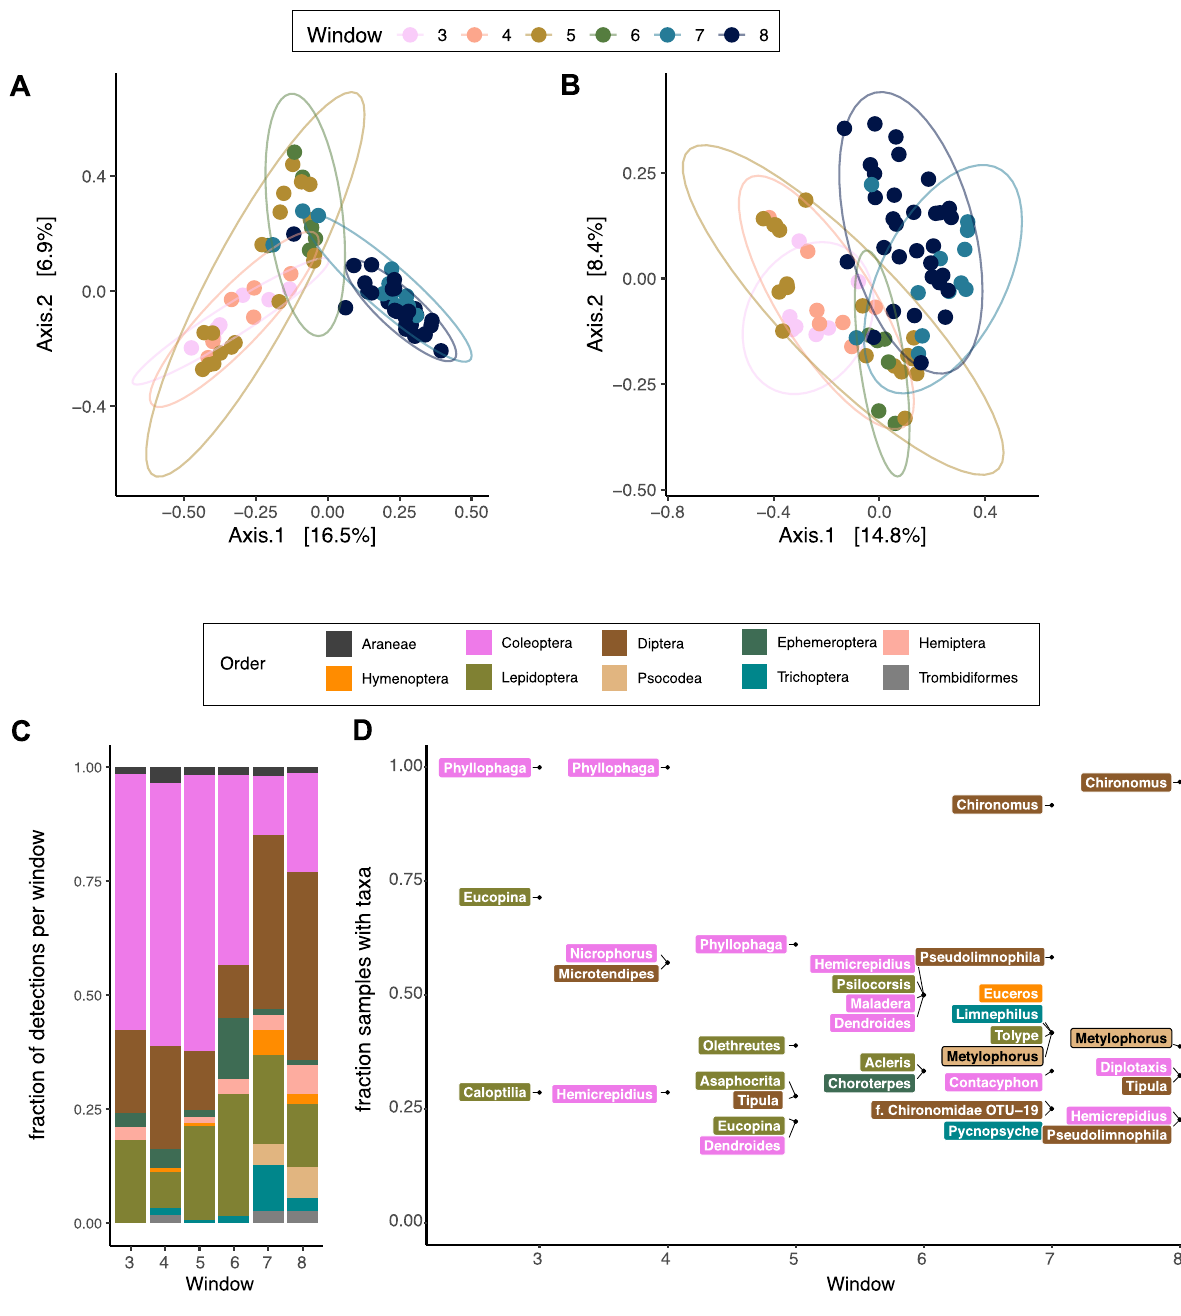
Figure 3. Changes in bat diet arthropod composition at one site. Compositional change at Fox State Forest (Hillsboro, NH, USA) throughout an entire foraging season in 2016. Sampling windows define 37-day periods beginning in early April and ending in late October. PCoA ordinations shown for ( a ) Dice-Sorensen index and ( b ) unweighted UniFrac distance metrics are grouped into early, mid, and late foraging season clusters; ellipses depict 95% confidence intervals around window group median. ( c ) The proportion of detections per arthropod order in a sampling window shift from being most represented by coleopteran taxa in early season to dipteran taxa in late season. ( d ) The fraction of samples with particular genera detected at each sampling window suggest specific taxa are major diet targets at different points of the foraging season. For example, coleopteran (Phyllophaga) in early sampling windows and dipteran ( Chironomus ) in late sampling